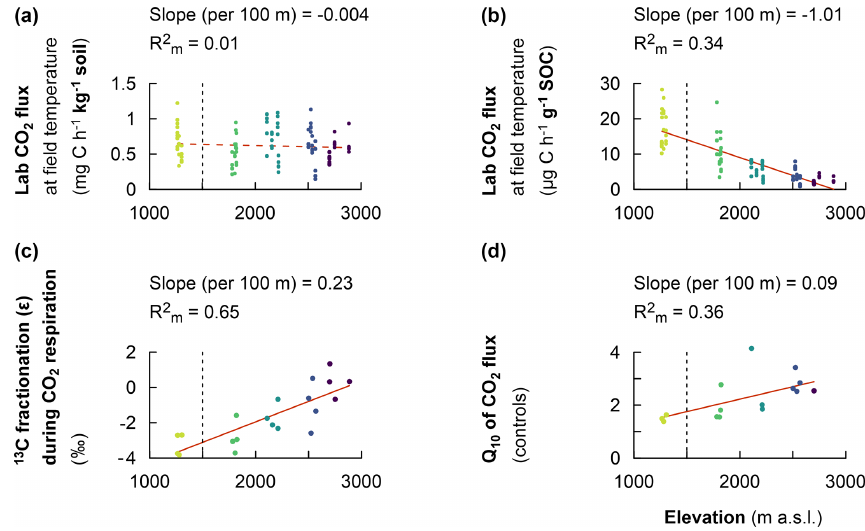
Figure 3. Fixed effect estimates of elevation (per 100m elevation increase) on response parameters. Laboratory-based heterotrophic CO 2 respiration rates at the corresponding mean in situ temperature (a) . The specific heterotrophic CO 2 respiration rates at the corresponding mean in situ temperature (b) . The 13 C isotopic fractionation during heterotrophic CO 2 respiration (c) . The temperature sensitivity of heterotrophic CO 2 respiration rates ( Q 10 ) (d) . The slope of the linear mixed effect model estimates per 100m of elevation increase is indicated (red solid line for a significant effect and red dashed line for no significant effect), as is the marginal R 2 ( R 2 m ), representing the fraction of the response variable explained by elevation. Plots from montane forest clusters (from 1750–3000ma.s.l.) were compared with a nearby premontane forest (separated by a vertical dashed line) at an elevation of